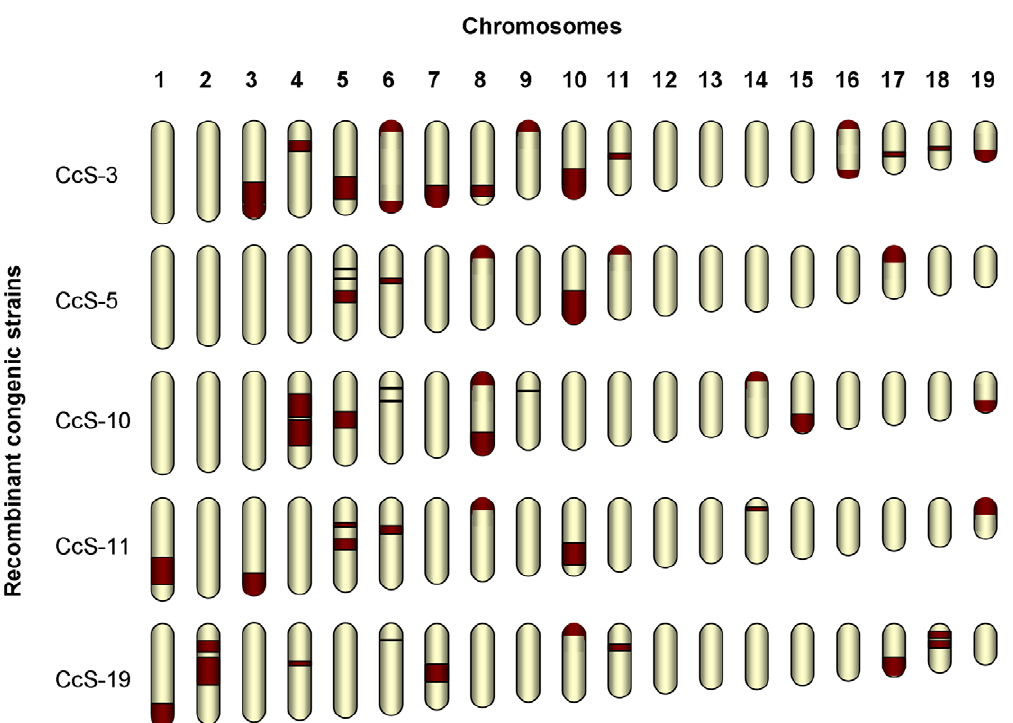
Figure 1. Schematic representation of the genetic composition of recombinant congenic (RC) strains. The major donor-strain regions of the CcS RC strains that were used to map colon or lung tumor susceptibility genes are shown based on real genotypes.